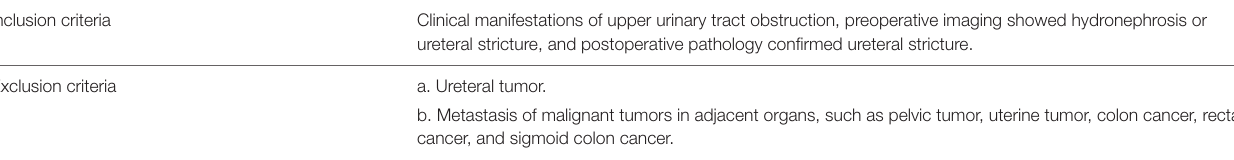
TABLE 1 | Inclusion and exclusion criteria.